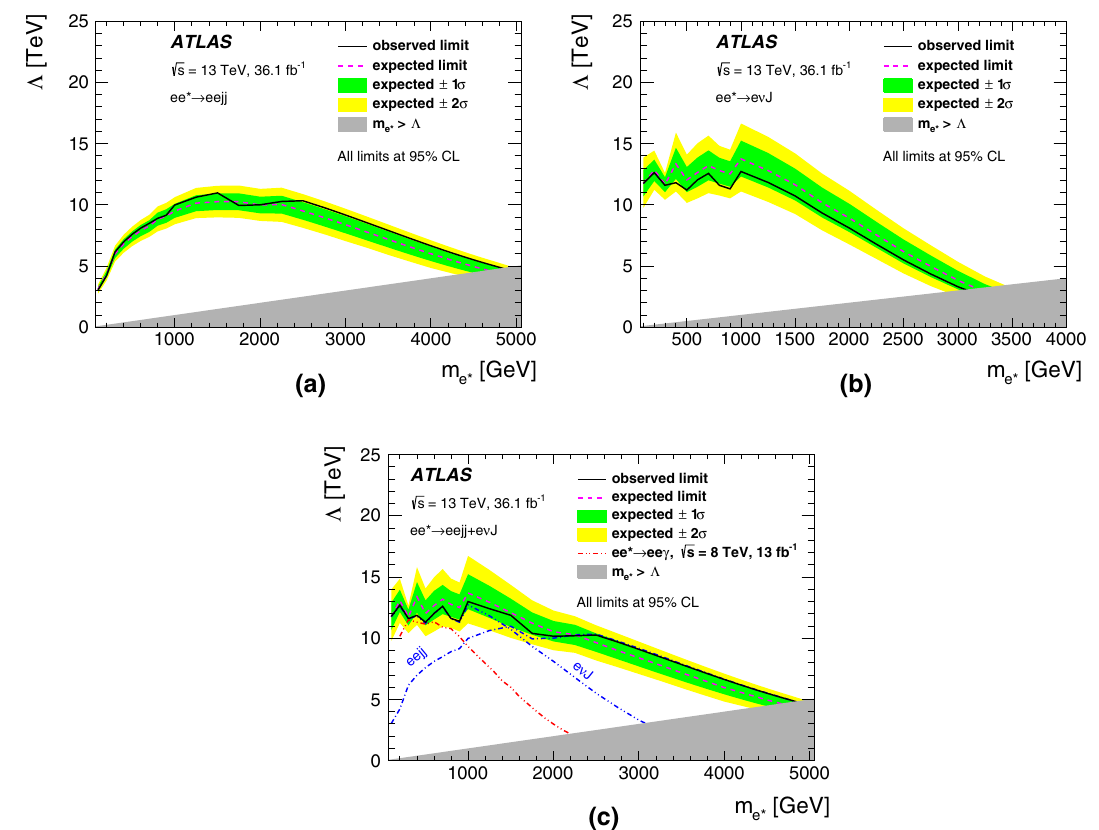
eejj (same as a ) and the e ν J (same as b ) channels are shown with the blue dot-and-dash lines in c for the reference. The exclusion limit set by ATLAS in the ee γ search channel [21] using 13 fb − 1 of data collected √ s = 8 TeV is also shown with the red dotted line in at